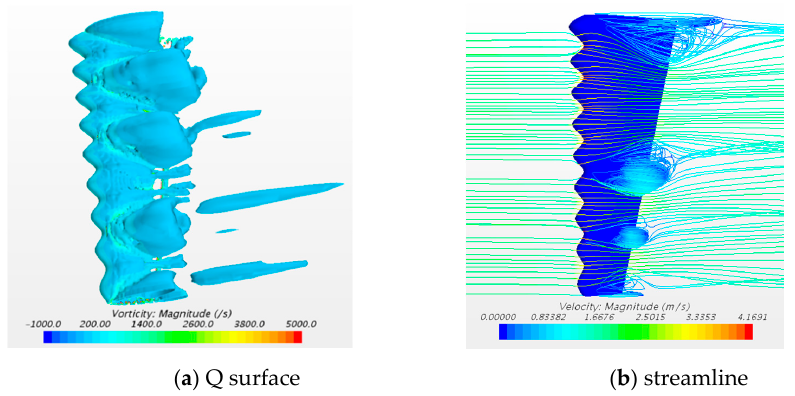
Figure 12. Vortex structures and streamlines near the surface of H15N9 when attack angle is 16° (the iso-surfaces in ( a ) corresponds to Q = 150 and velocity magnitude contour of streamline in ( b )).